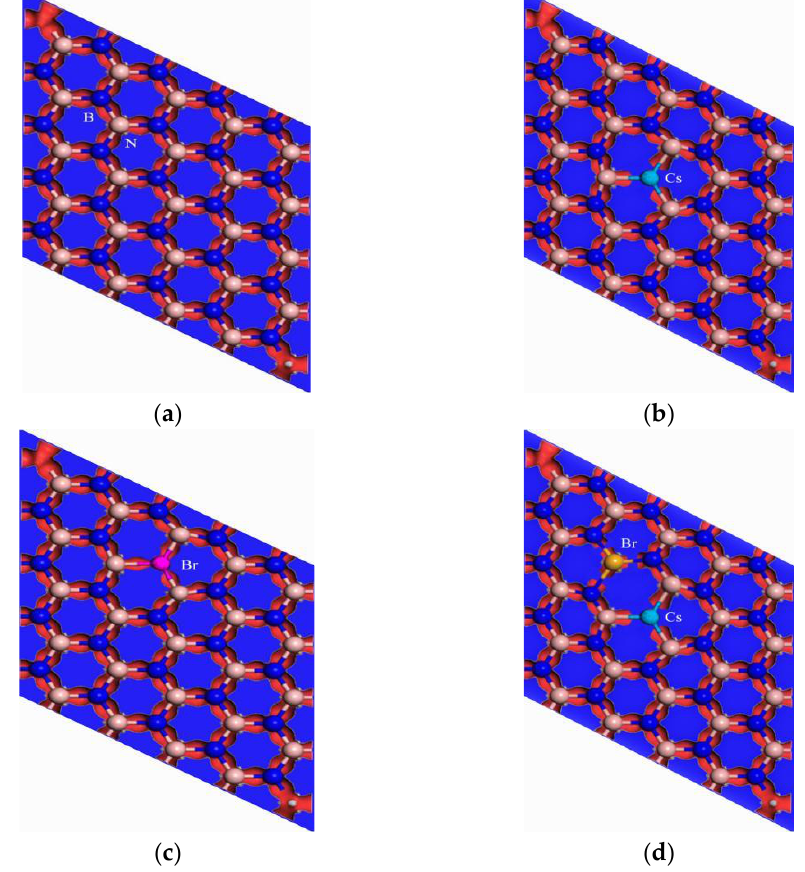
Figure 7. Electron density of intrinsic and doped h-BN charges. ( a ) intrinsic, ( b ) Cs-doped, ( c ) Br-doped and ( d ) Cs-Br co-doped h-BN.